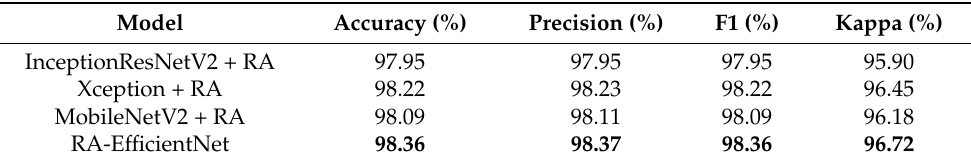
Table 3. Comparison of different CNN networks with RA block for Task 1.